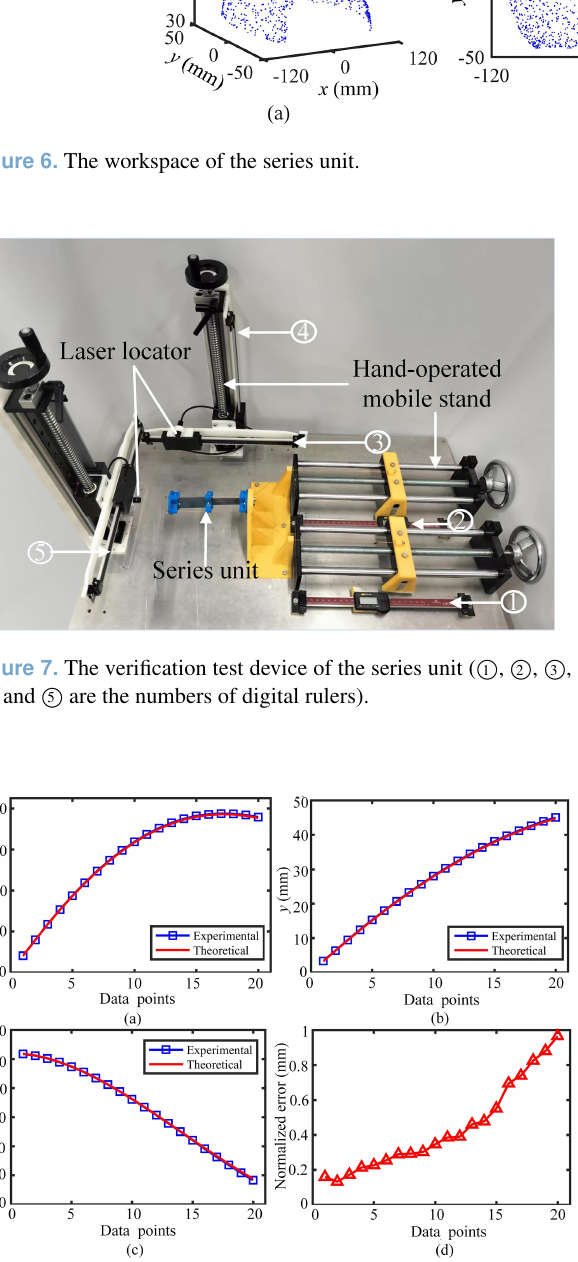
Figure 8. (a–c) The experimental tip position coordinates of the se- ries unit at each data point are compared with the theoretical results. (d) The normalised errors at each data point.